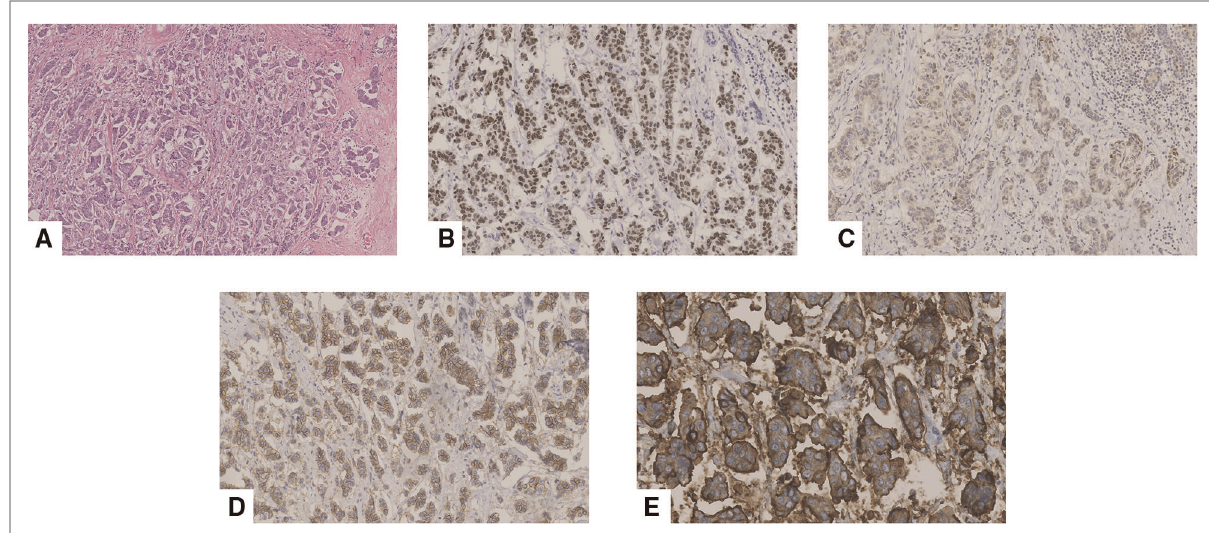
FIGURE 7 Pathological features of an invasive micropapillary carcinoma (IMPC) in a 43-year-old woman who underwent mastectomy. ( A ) Hematoxylin-eosin (H&E) staining indicated that the breast tumor was composed of morula-like clusters fl oating in empty, clear spaces lined by delicate strands of stroma (original magni fi cation ×100). Immunohistochemical staining of ( B ) estrogen receptor (ER, original magni fi cation ×200), ( C ) progestogen receptor (PR, original magni fi cation ×200), ( D ) human epidermal growth factor receptor-2 (HER-2, original magni fi cation ×200), and ( E ) Mucin-1 (original magni fi cation ×400), respectively. More than 90% of ER demonstrated strong positive. 10% of PR was diagnosed as weak to moderate intensity positive. HER-2 staining indicated positive (2+). Mucin-1 staining demonstrated “ inside-out ” pattern was strong positive in cavity